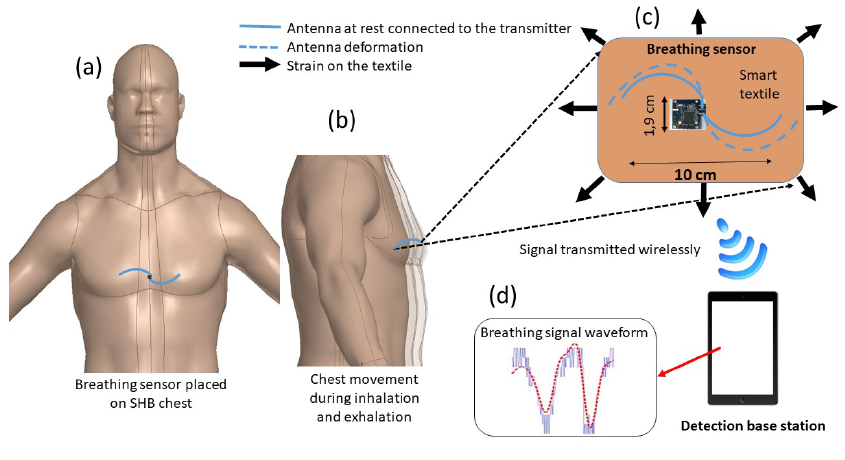
Figure 1. Schematic representation of the working principle: ( a ) Breathing sensor is placed on the chest of the simulated human body (SHB); ( b ) the sensor is stitched onto the elastic textile and it follows the movements of the chest wall, inducing a deformation of the spiral fiber antenna shape; ( c ) the sensor is strained by the chest movements, so the transmitted signal changes during breath; ( d ) the signal is detected wirelessly by a base station.